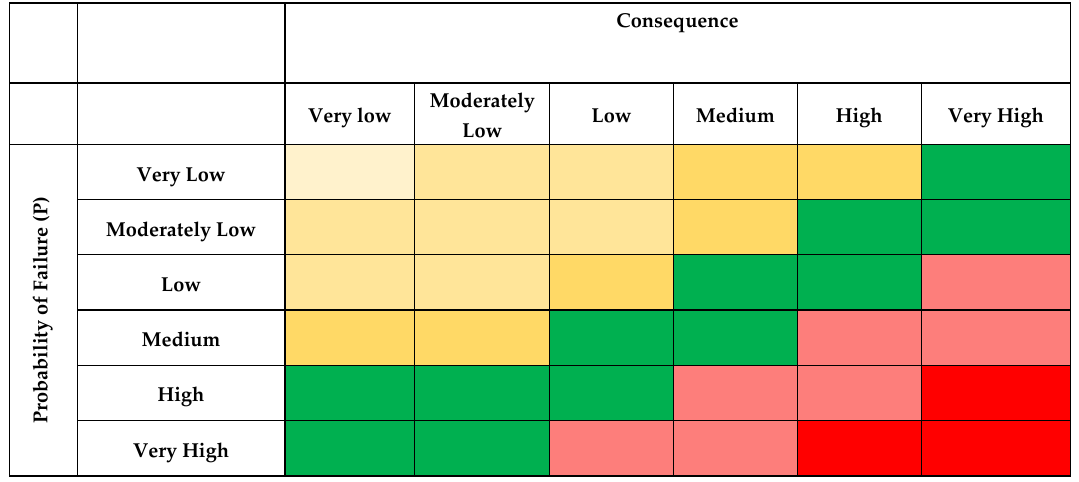
Figure 3. Risk Matrix used for water quality assessment in present study.